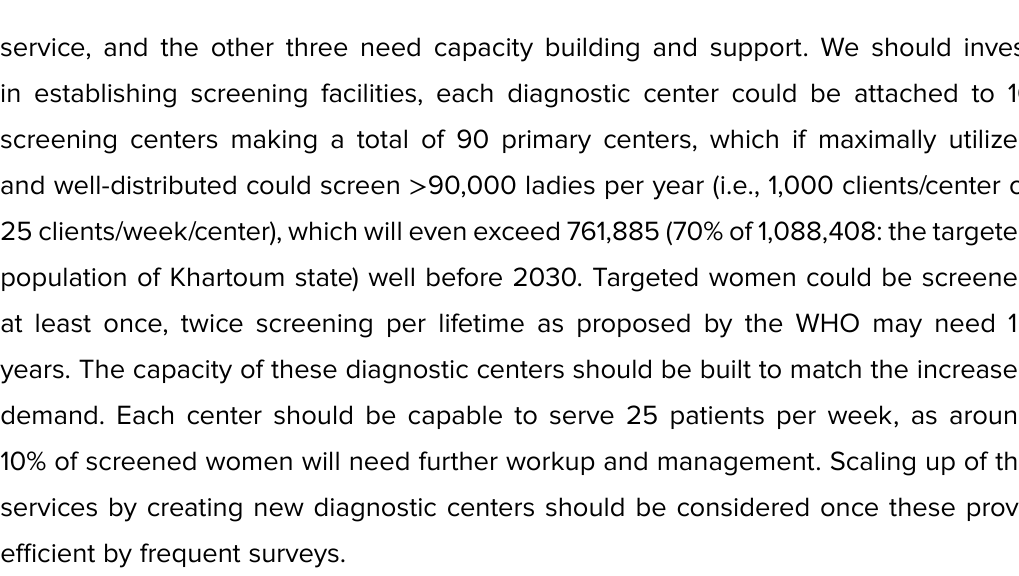
Figure 5: Link between primary and secondary care